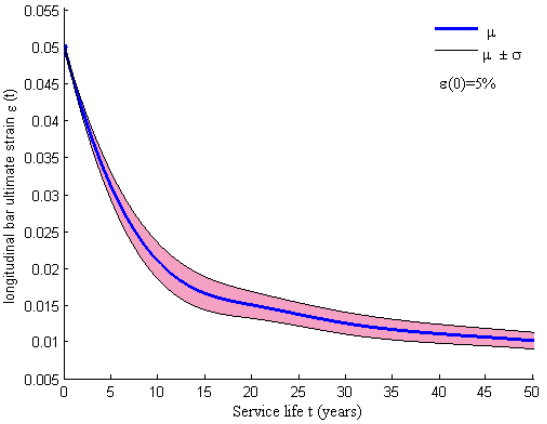
Figure 5. Ultimate strain of a longitudinal bar over time.